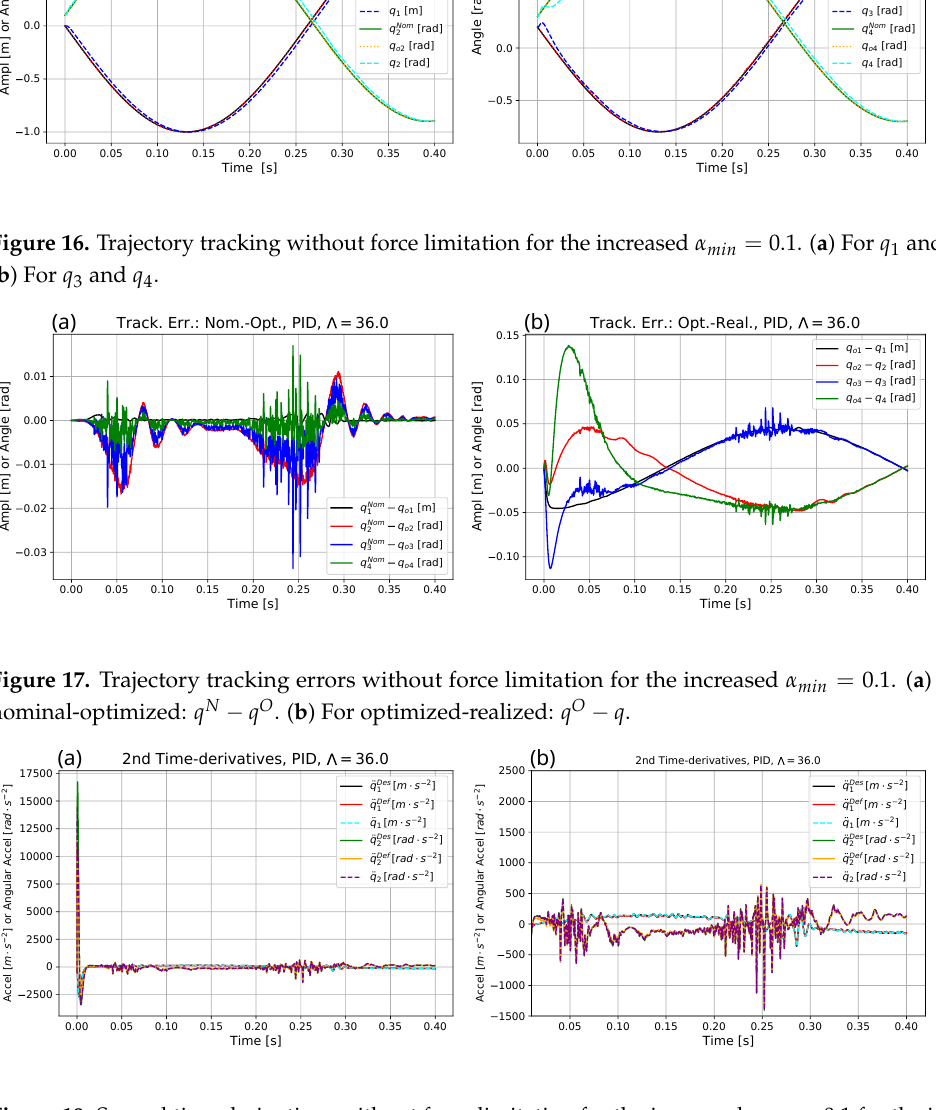
Figure 18. Second time derivatives without force limitation for the increased α min = 0.1 for the joint coordinates q 1 ( t ) and q 2 ( t ) . ( a ) In full scale. ( b ) Without the initial